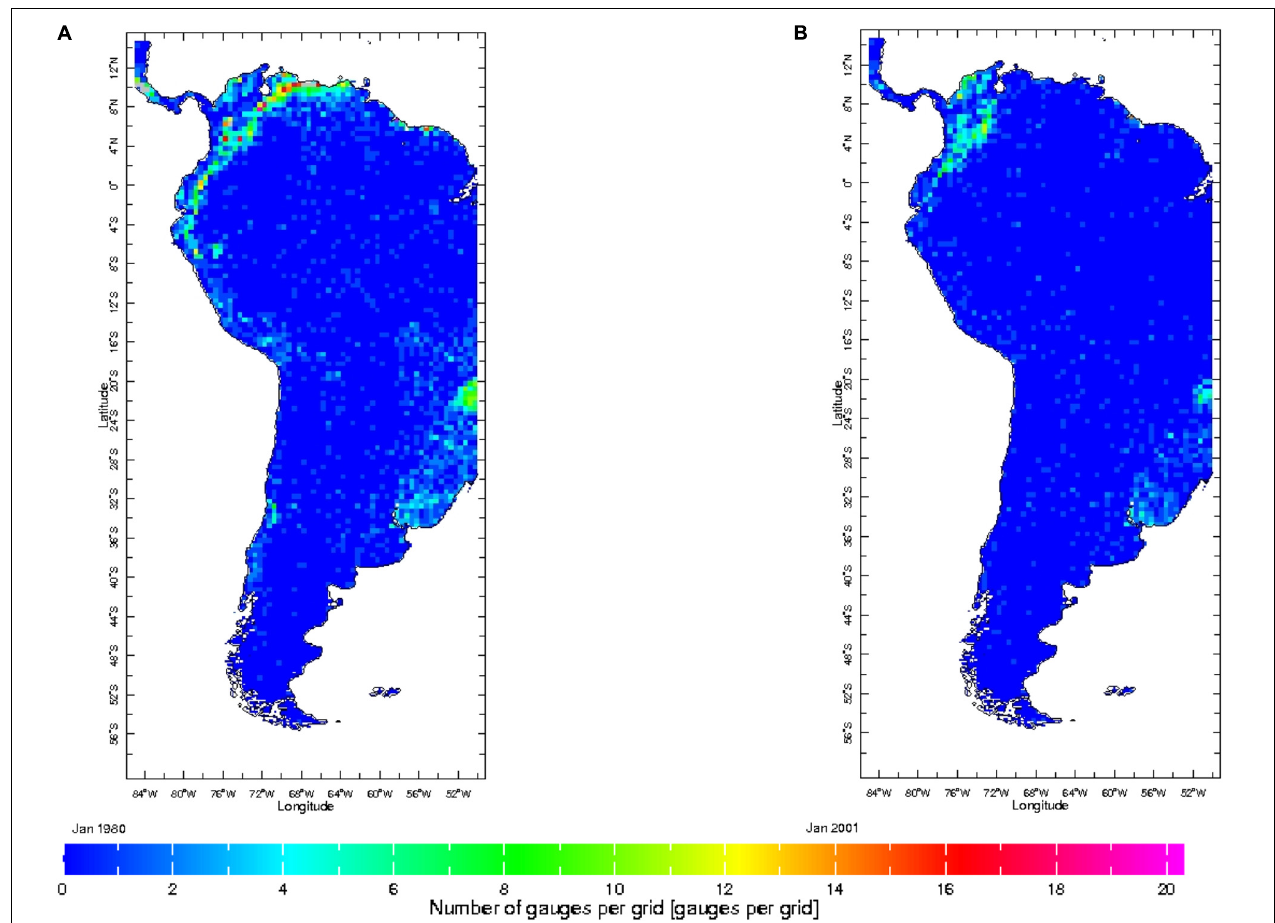
FIGURE 6 | Spatial distribution of the average number of rain gauges per grid used in GPCC 4 over the period (A) 1980–2000 and (B) 2001–2018.